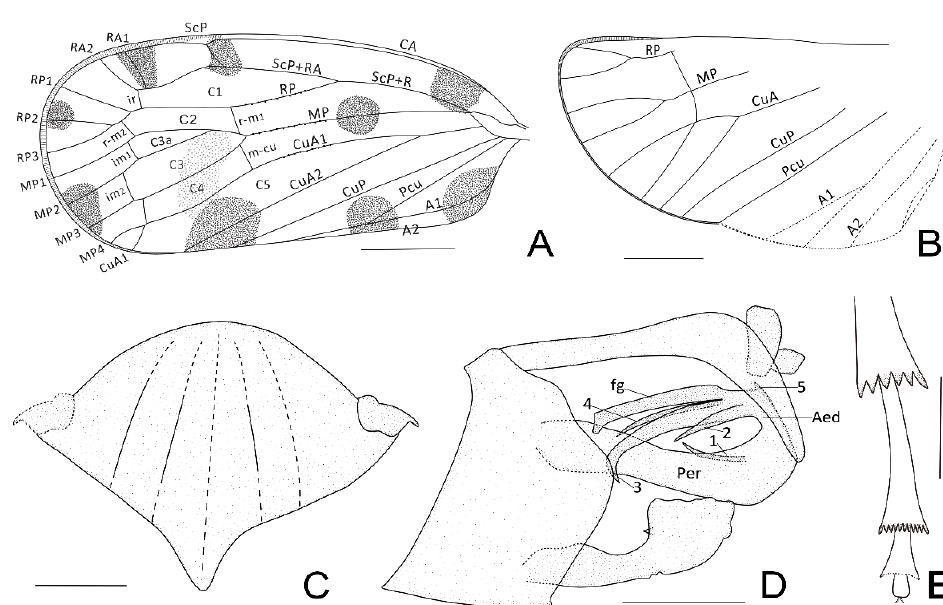
Figure 3. Maculixius jiewenae sp. nov. , Holotype, MDHP11, line drawings. ( A ) Forewing schema. ( B ) Hindwing schema (claval part in dotted line difficult to observe). ( C ) Mesonotum, dorsal view. ( D ) Male terminalia, lateral view. ( E ) Apex of hind leg, lateral view (spines on tarsomere II in dotted line difficult to observe). Scale bars: 1 mm in ( A , B ), 0.5 mm in ( C , D ), 0.3 mm in ( E ). The abbreviations and numbers refer to the text.